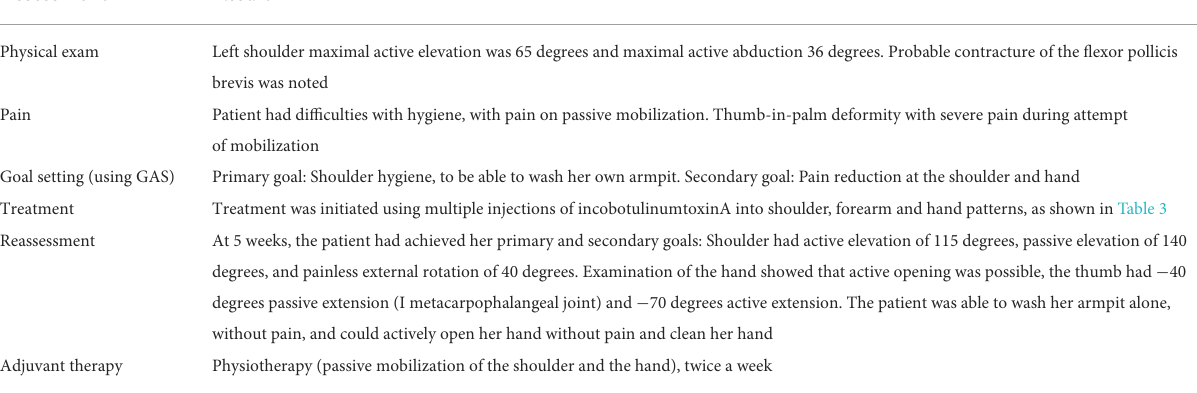
TABLE 5 Case 3: A 42-year-old female patient who, after a series of strokes between 5 and 12 years prior, initially presented with the appearance of left thumb-in-palm deformity and adducted shoulder, was treated with incobotulinumtoxinA and then lost to follow-up.